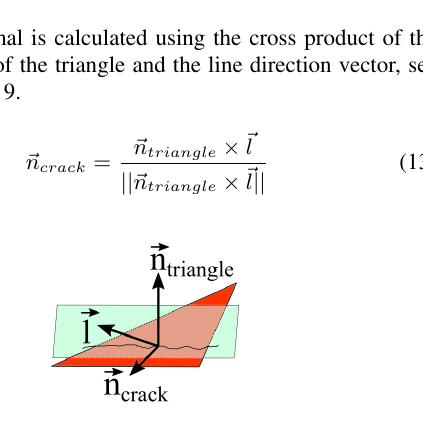
Figure 9. The crack normal is perpendicular to the line direction and the normal of the